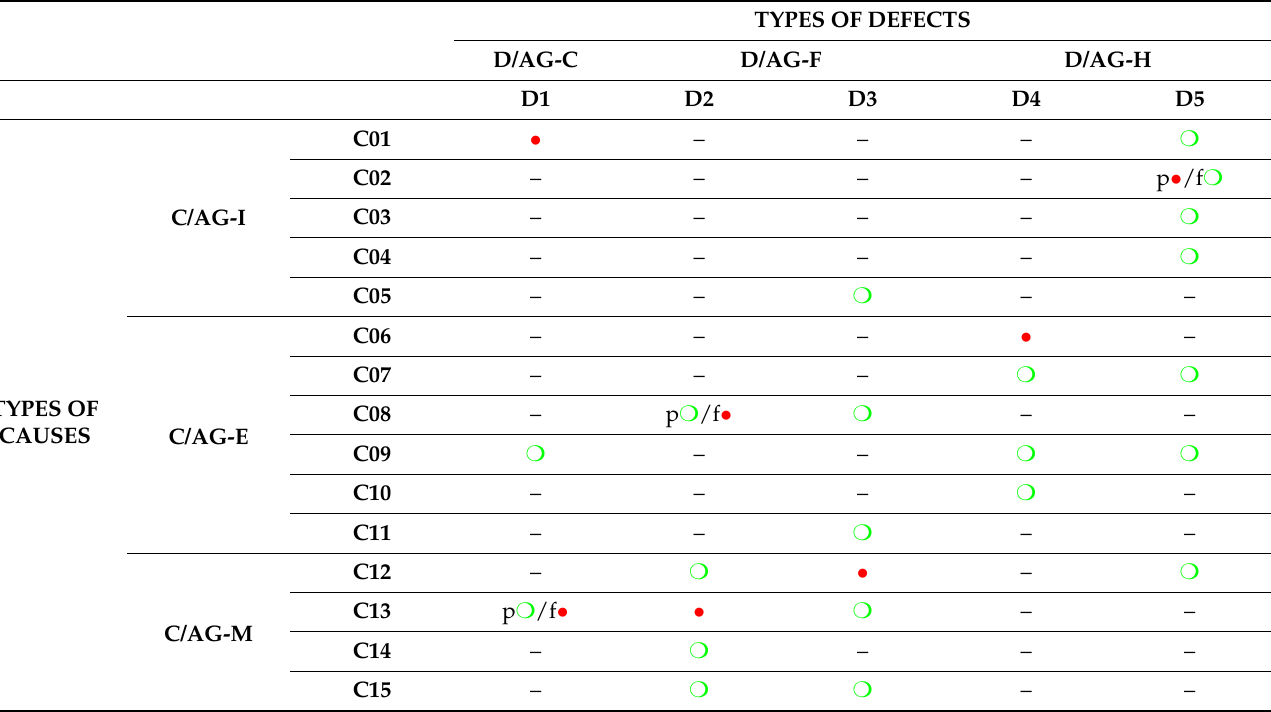
Table 2. Quadrant of construction interrelations between the types of defects and the types of